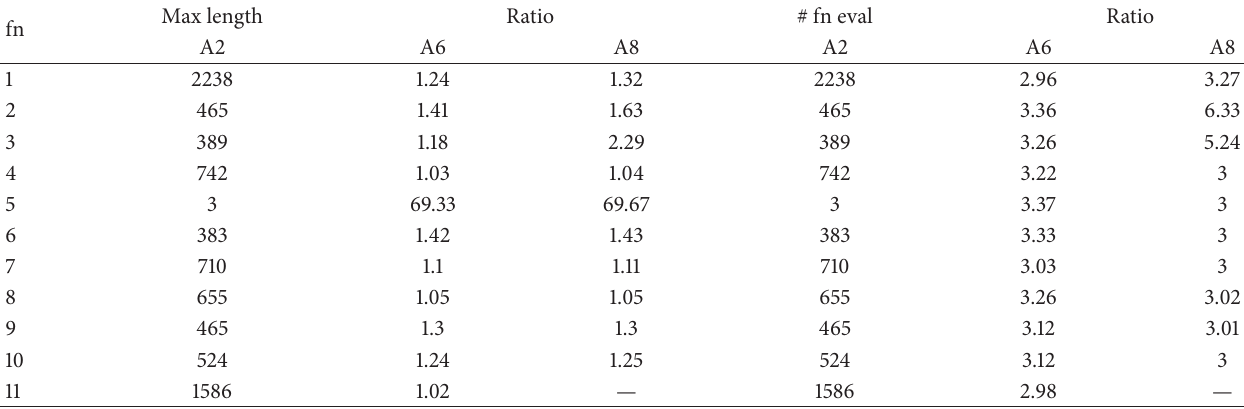
Table 9: The maximum list length from A2 and the ratio of the maximum list length from Algorithms A6 and A8 to the maximum list length from A2 when 𝑛 = 100 . Also the result of the total number of function evaluations ( 𝐹 and 𝑓 ). fn